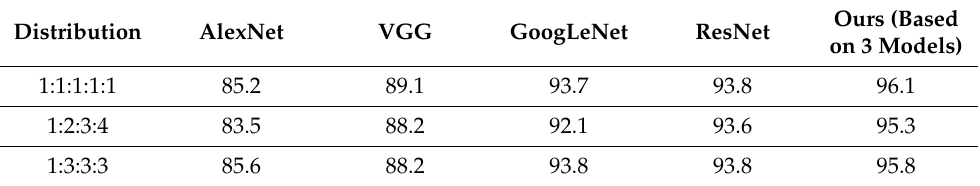
Table 10. Accuracy of different models with different dataset